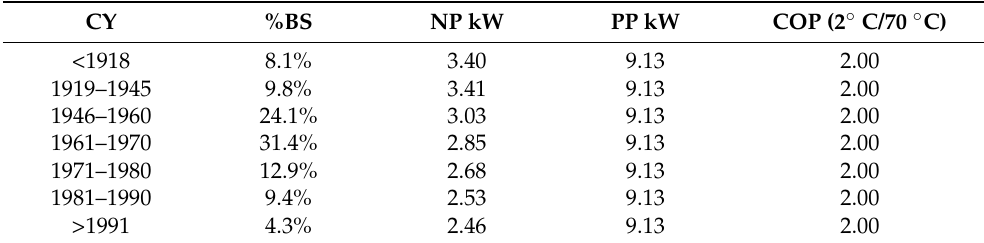
Table 4. Nominal power (NP), plate power (PP) and COP of the HP appropriate for the design value of the outdoor temperature of Salerno (2 ◦ C), per construction year CY (outlet water temperature 70 ◦ C) and portion of the building stock %BS. CY %BS NP